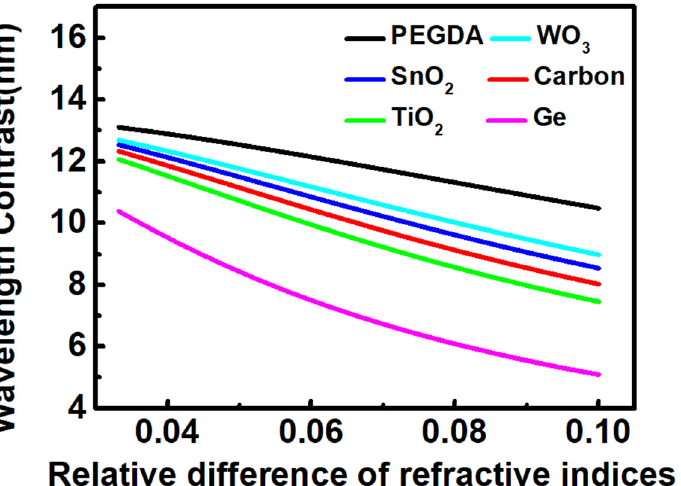
Figure 3. The relationship between the wavelength range contrast ( Δ λ contrast ) and the relative dif- ference of refractive index between external Substance 1 and Substance 2 ( Δ n s-r ).